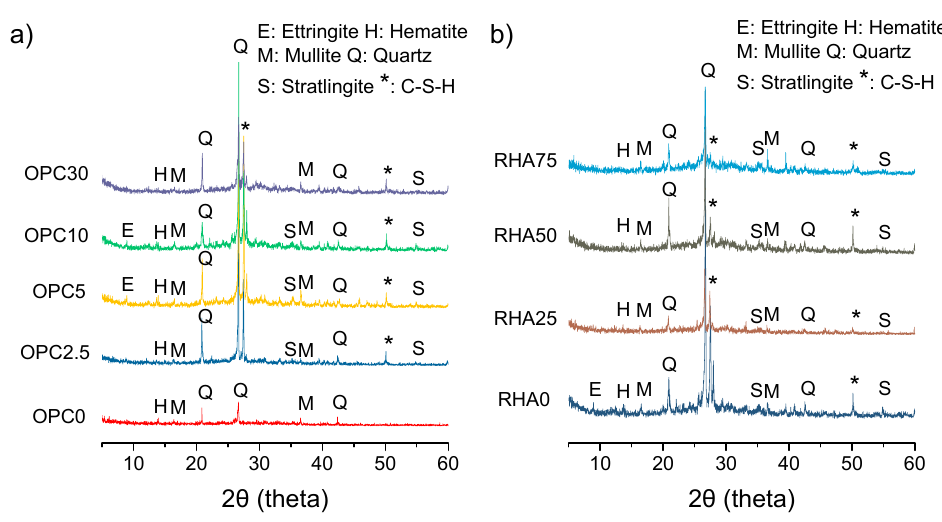
Figure 12. X-ray diffractogram patterns: ( a ) Binary mixes ( b ) Ternary mixes samples.